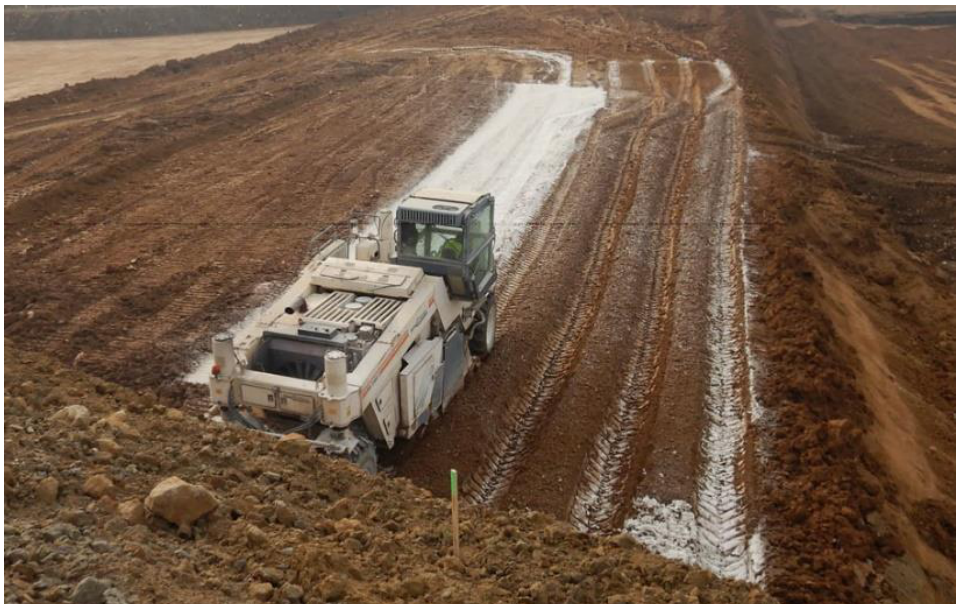
Figure 4. Lime stabilisation. MPH 600 recycler (photo: Michal Bernacki). Table 5. Chemical characteristics of quicklime as a building material [50].